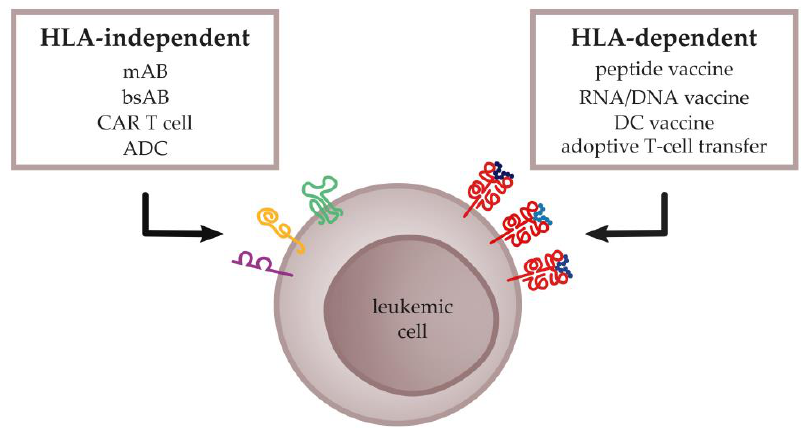
Figure 1. Schematic overview of human leukocyte antigen (HLA)-independent and HLA-dependent antigen-specific cancer immunotherapy approaches. The HLA-independent approach focusses on antibody-based technologies targeting surface structures via e.g., monoclonal antibodies (mABs), bispecific antibodies (bsABs), chimeric antigen receptor (CAR) T cells, or antibody-drug conjugates (ADCs). HLA-dependent immunotherapies induce peptide-specific immune responses mainly by peptide-, RNA/DNA-, or dendritic cell (DC)-based vaccines, and adoptive transfer of activated or T-cell receptor-transduced T cells.